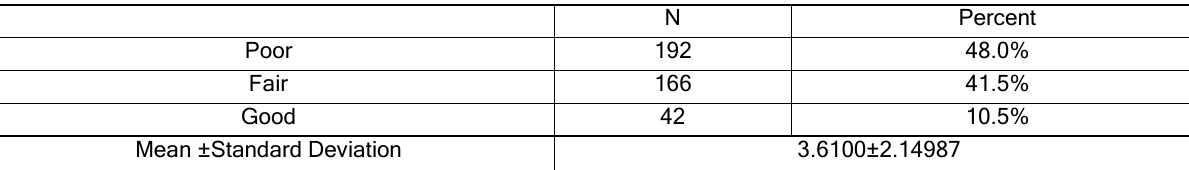
Table 3: frequency of knowledge score among the